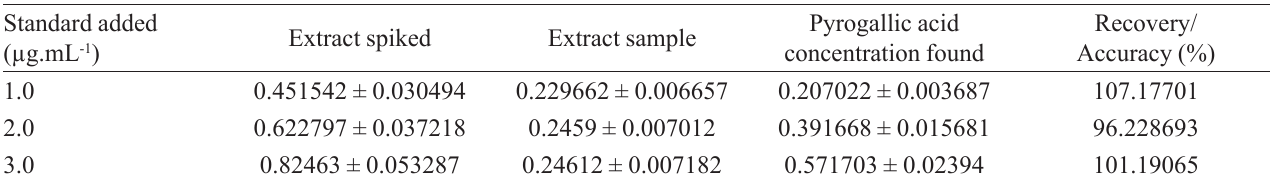
TaBLe IV - Recovery/accuracy for polyphenols not-absorbed by the skin powder presented in the Syzygium cumini (L.) Skeels extract Standard added